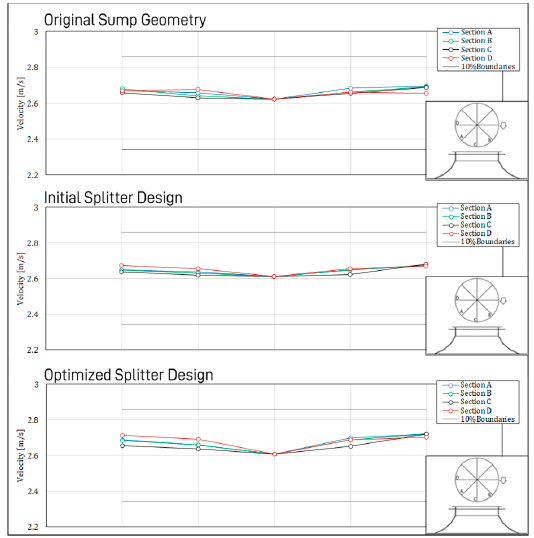
Figure 24. Point velocity taken on points on a plane across the impeller eye (CFD).